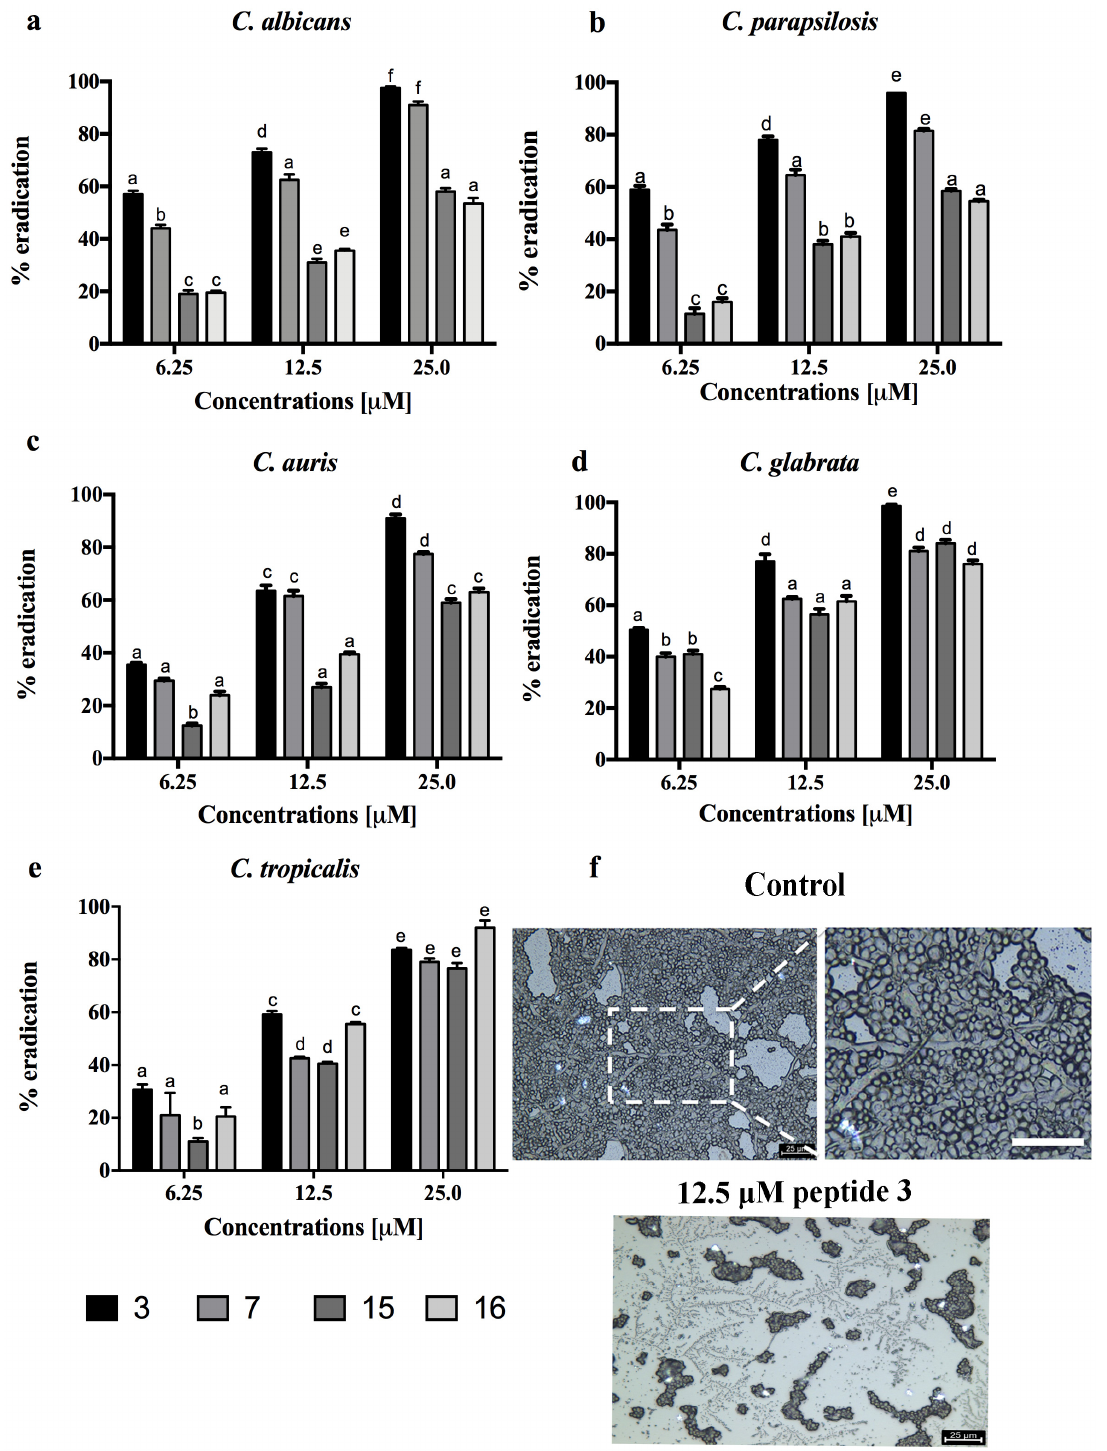
Figure 3. Evaluation of biomass reduction in biofilms quantified with XTT of the five Candida species after treatment with peptides 3 , 7 , 15 and 16 at the same sub-MIC concentrations (6.25, 12.5 or 25.0 µ M) ( a – e ). Data with different letters (a–f) are significantly different ( p < 0.05, Tukey’s). ( f ) The eradication effect of peptide 3 on preformed C. albicans ATCC 90028 biofilms was evaluated by bright field microscopy. Scale bars represent 25 μ m.